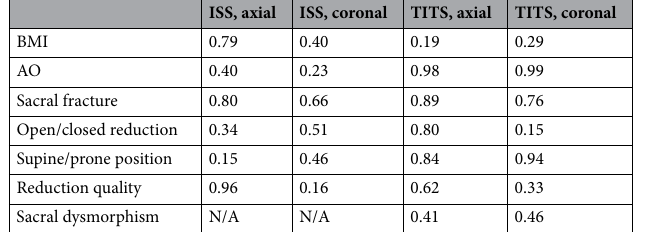
Table 4. Logistic regression of risk factors for mal-angulation of the ISS and TITS. ISS iliosacral screw, TITS trans-iliac trans-sacral screw, BMI body mass index, AO Arbeitsgemeinschaft für Osteosynthesefragen, N/A not available.